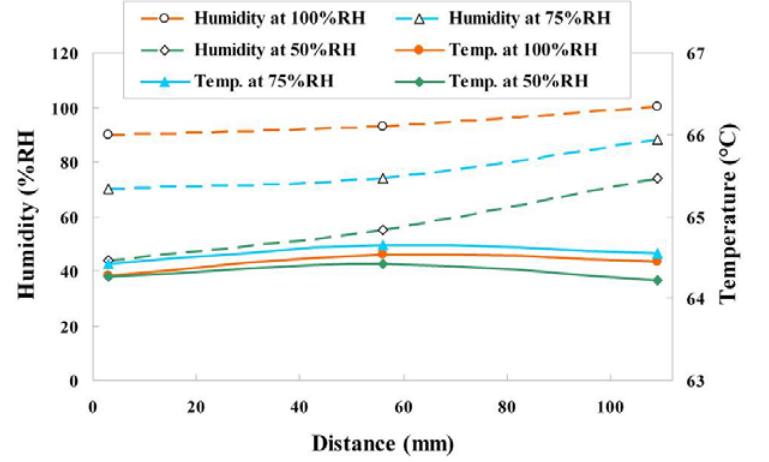
Figure 15. Variation of temperature and humidity at upstream, midstream and downstream (0.1 A/cm 2 ).